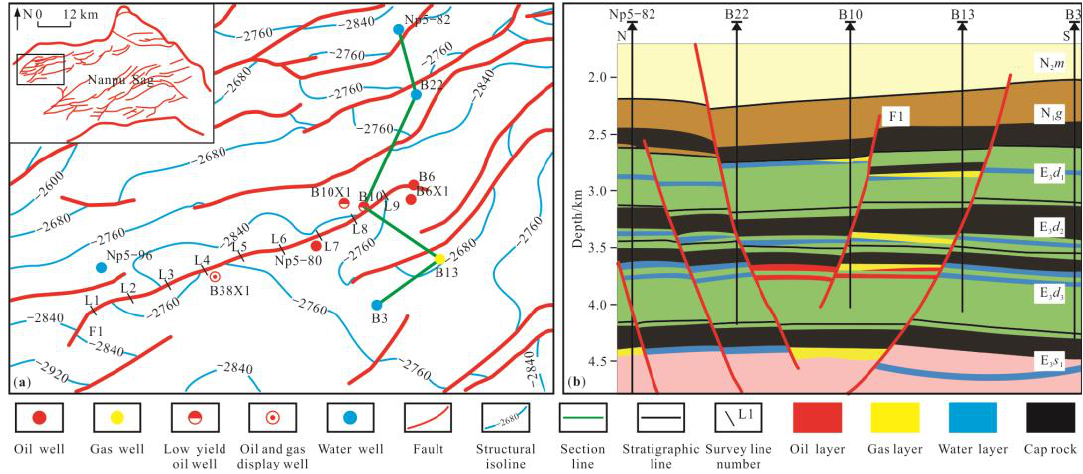
Figure 1. Relationship between the F1 Fault and oil – gas distribution in the Nanpu 5th Structure: ( a ) plan; ( b ) section views.